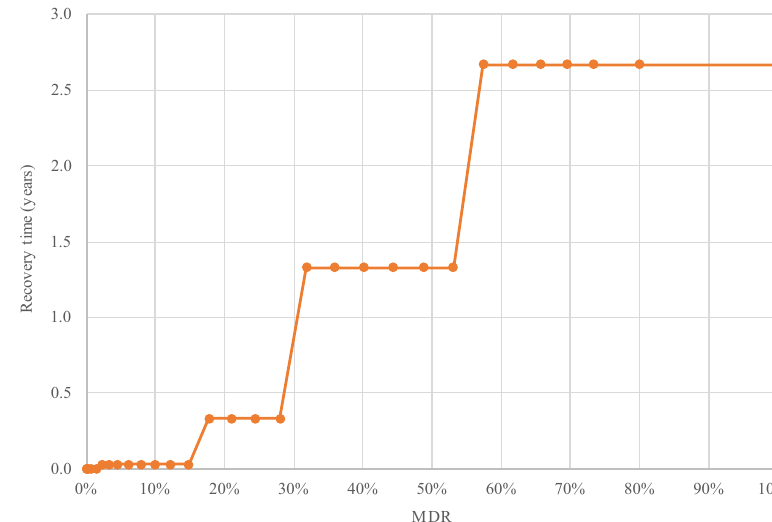
Fig. 2 Recovery times based on MDR for multifamily units